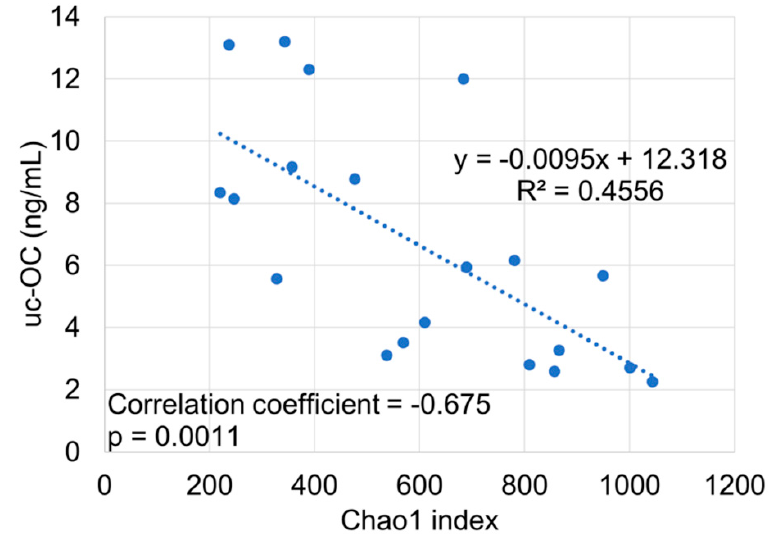
Figure 2. Correlation between undercarboxylated osteocalcin concentration and mean Chao1 index in cases of low activity. There was also a significant negative correlation between undercarboxylated osteocalcin concentration and mean Chao1 index in cases of low activity (Crohn’s Disease Activity Index: CDAI < 150). uc-OC, undercarboxylated osteocalcin.